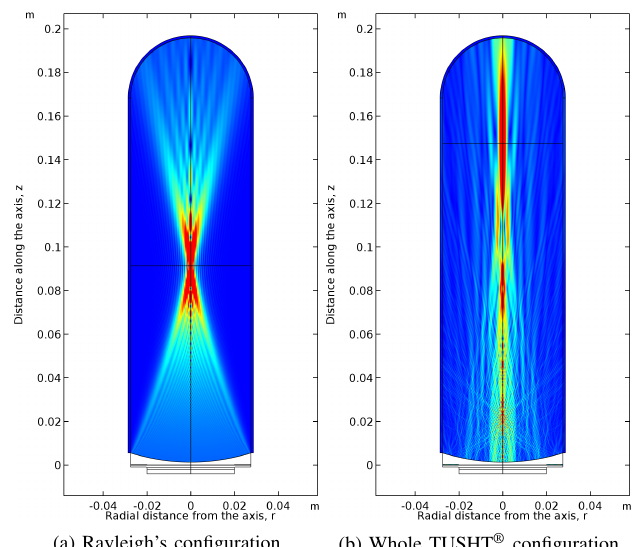
Fig. 9. 2D view of the radiated field of the sensor at 4.5 MHz with depiction of the evaluation axis (z-axis and focal spot r-axis).